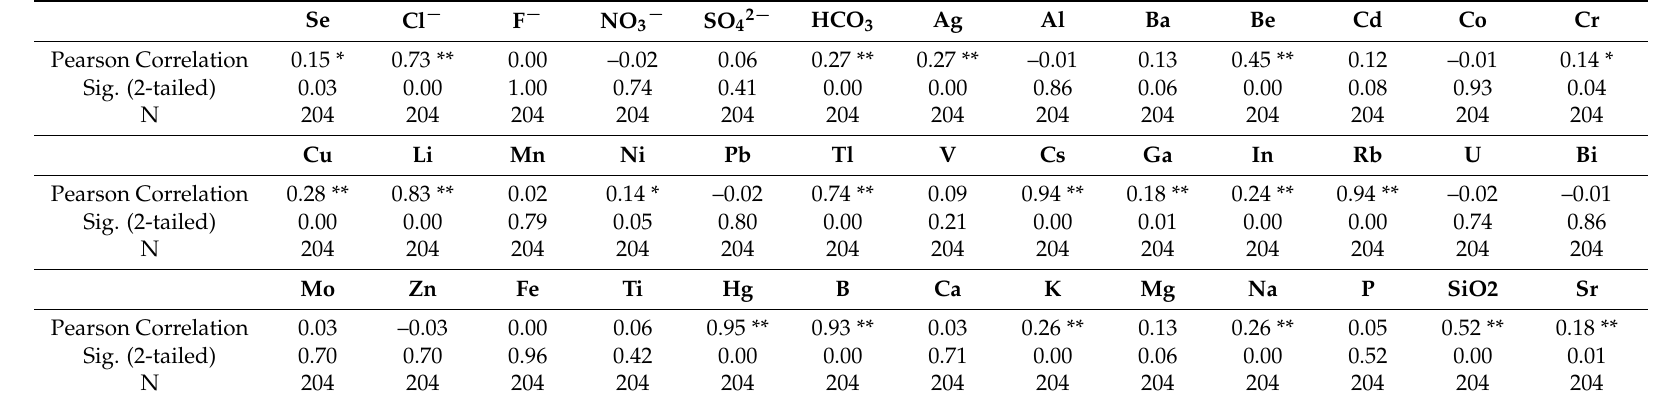
Table 1. Correlations between arsenic and other